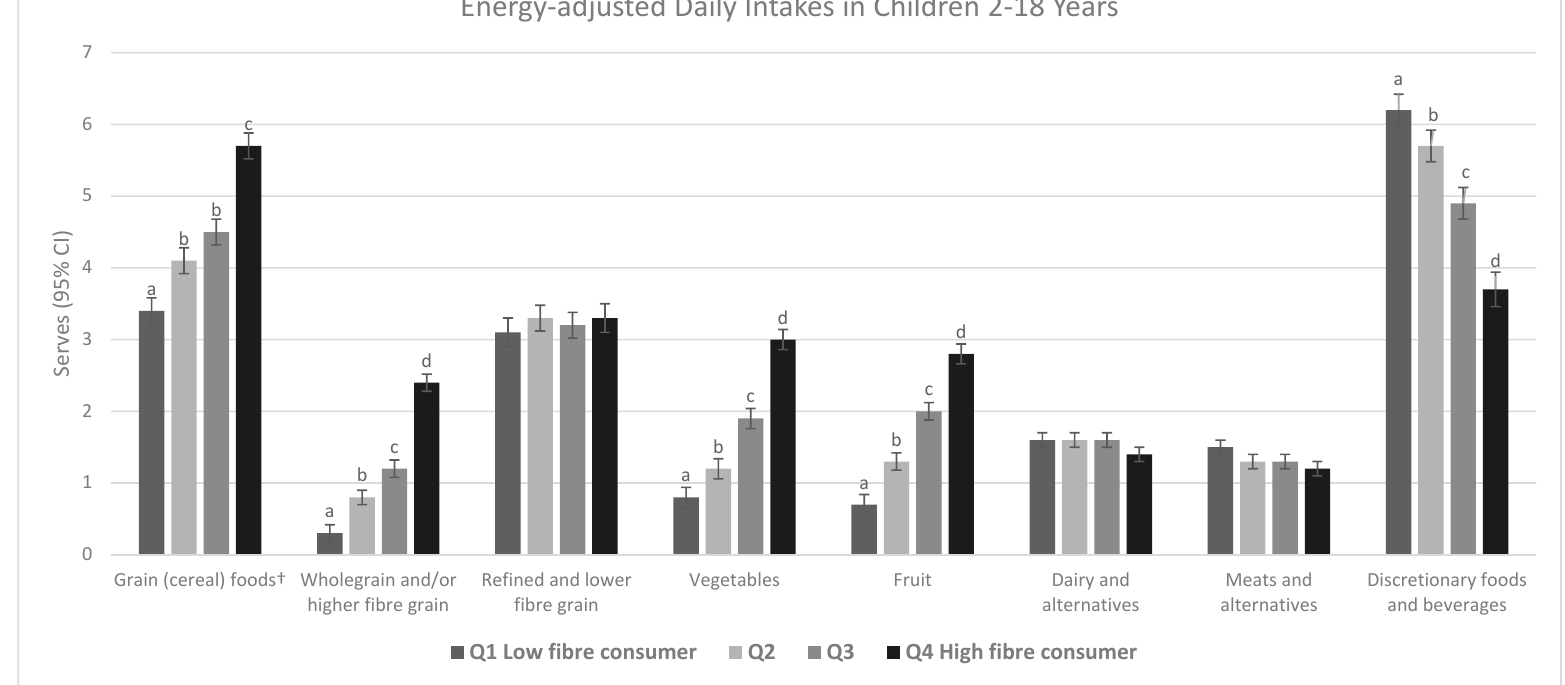
Figure 1. Energy-adjusted mean daily serves among children aged 2–18 years, from the Australian Dietary Guidelines five food groups and discretionary foods and beverages by quartile of fibre intake. a, b, c, d denote significant difference between quartiles ( p < 0.001). Marginal mean serves from general linear models adjusted for energy intake. † Includes wholegrain and/or higher fibre grain, and refined and lower fibre grain.